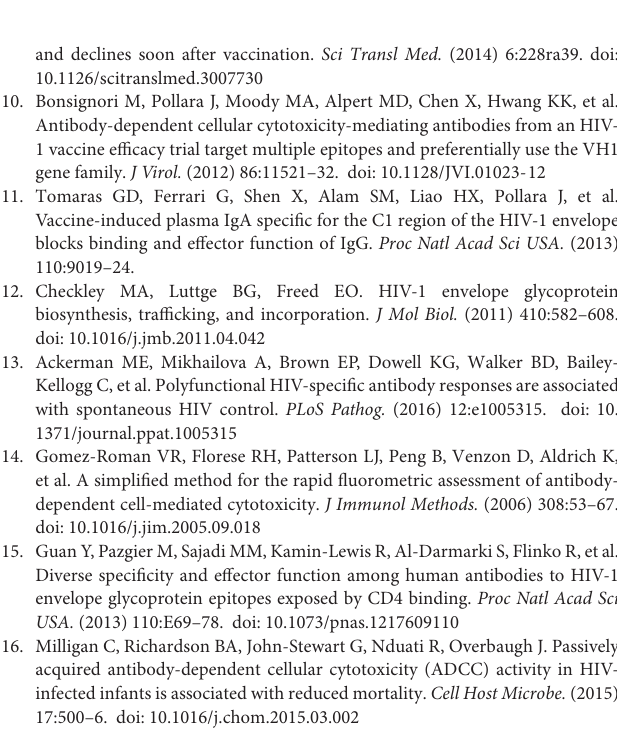
Supplementary Figure 1 | Frequency of Annexin V + target cells generated by negative control conditions in an antibody dependent cellular cytotoxicity (ADCC) assay. The y-axis shows the frequency of Annexin V + target cells generated in an ADCC assay as described in the methods section. Target cells included siCEM cells tested 3 times and HIV uninfected CEM cells (negative control). Target cells were opsonized with 50 or 500 µ g/ml of IgG from the positive control HIVIG, a pool of plasma from HIV negative subjects (HIV − Ig #1), IgG from HIV negative serum (HIV − Ig #2) and no antibody. Each antibody concentration and the no antibody wells were tested in duplicate and each symbol represents the mean of duplicate determinations. Supplementary Figure 2 | Visualization of antibody dependent cellular trogocytosis (ADCT) using ImageStream R (cid:13) . Single monocytes acquire pieces of membrane from HIVIG opsonized gp120-coated CEM cells labeled with CFSE and PKH-26. (A) Three single gp120-coated CEM cells positive for the fluorochromes FITC (CFSE) and PE (PKH-26) but not for BV786 (CD14). (B) Three single monocytes as shown by the positive signal for the BV786 fluorochrome conjugated to anti-CD14, after a one-hour incubation with CFSE + PKH26 + gp120-coated CEM cells and HIVIG. Membrane (PKH-26) but not cytosolic (CFSE) material was transferred to gp120-coated CEM cells by ADCT to single monocytes as demonstrated by the absence of doublets by bright field microscopy. Supplementary Figure 3 | Quantification of total IgG in HIV + plasma. Plasma samples from 18 UTPs, 24 TPs, 37 ECs and 16 VCs were quantified for total IgG using a plate-based human IgG ELISA quantification kit. Supplementary Figure 4 | Quantification of Ab-dependent (AD) functions in HIV + plasma. Shown are the results generated by HIV + plasma from 18 UTPs, 24 TPs, 37 ECs and 16 VCs tested for (A) ADCP, (B) ADCD, (C) ADCC and (D) ADCT as in Figure 2 . Results shown were background subtracted but were not normalized to the concentrations of their internal HIVIG positive controls. Panels (A–D) display the results generated by HIVIG present in the 9, 5, 8 and 8 96-well plates, respectively, used to test these AD functions. AUC = partial area under the curve; PS = phagocytic score; CDS = complement deposition